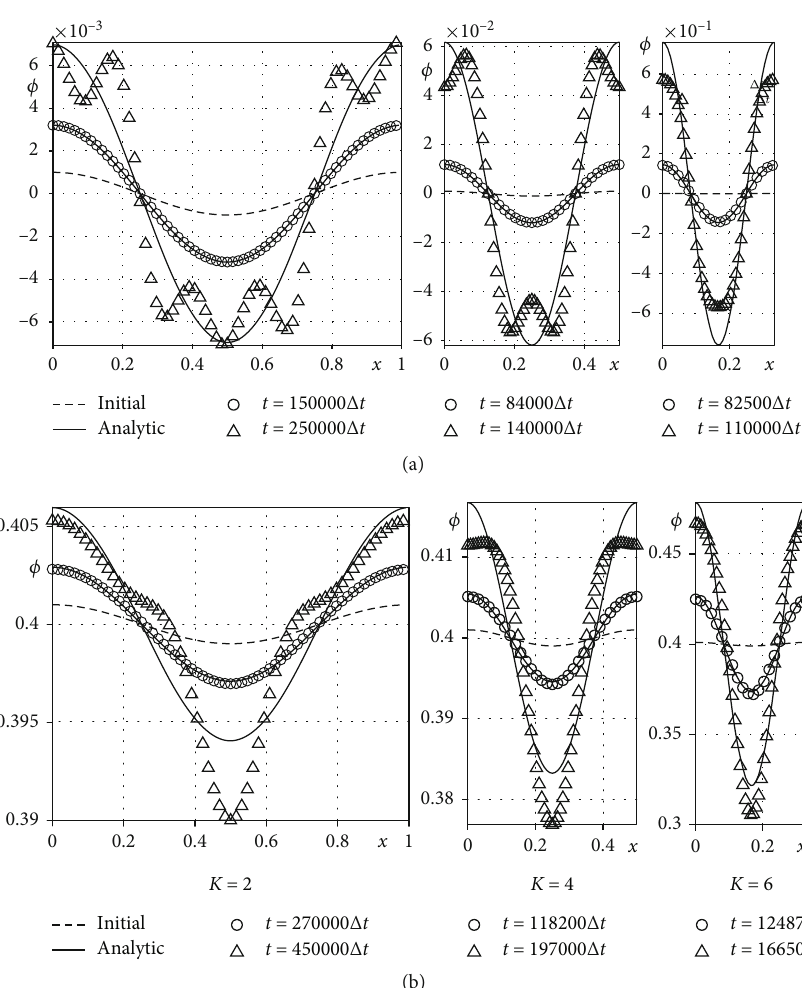
Figure 4: Numerical solution and theoretical solution at spinodal position (a) ϕ